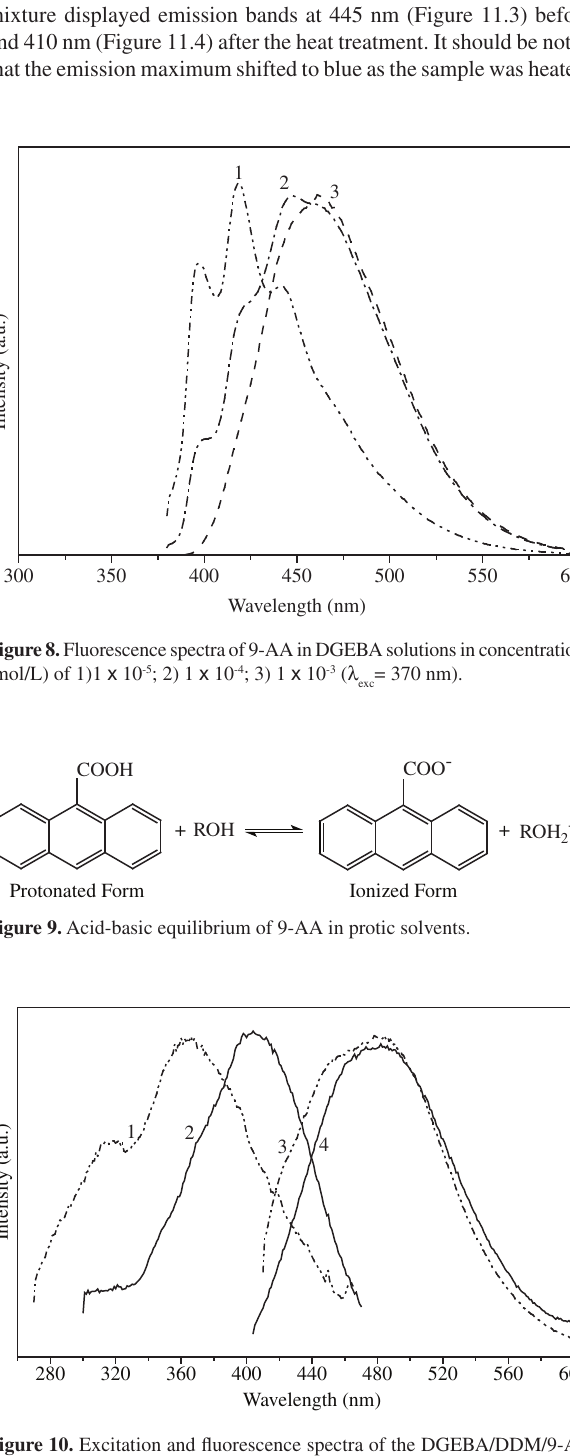
Figure 10. Excitation and fluorescence spectra of the DGEBA/DDM/9-AA mixture: excitation monitored at 1) 480 nm and 2) 486 nm, fluorescence excited at 3) and 4) 395 nm. Dashed lines refer to the DGEBA/DDM/9AA mixture before heat-treating; full lines refer to the DGEBA/DDM/9AA mixture after heat-treating at 120 °C for 2 h (5 °C/min heating